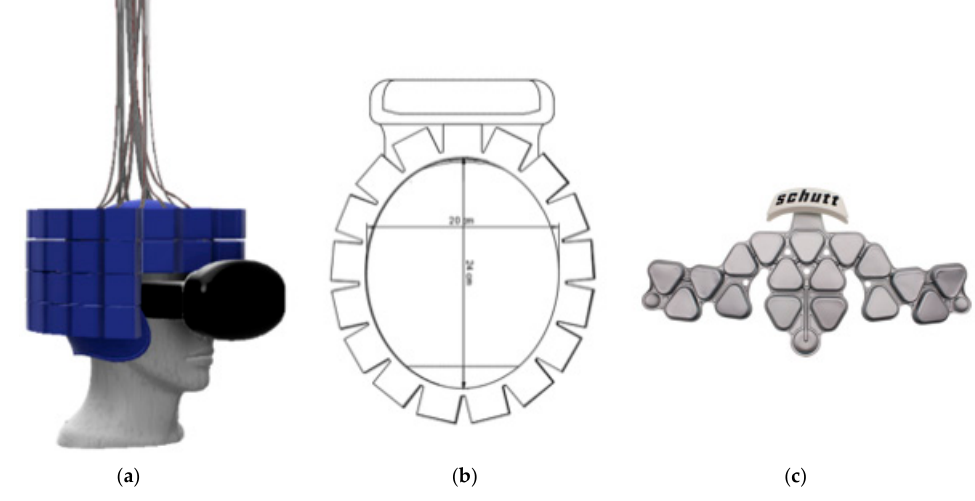
Figure 8. ( a ) Four-tiered 3D helmet render with VR set, 18-18-15-15 module ring; ( b ) top view of the 4-tiered ring design with dimensions; ( c ) Football helmet air bladder to be used as a concept in the 3D printed helmet for a tight, comfortable fit (Photo courtesy of Schutt Sports) [19].